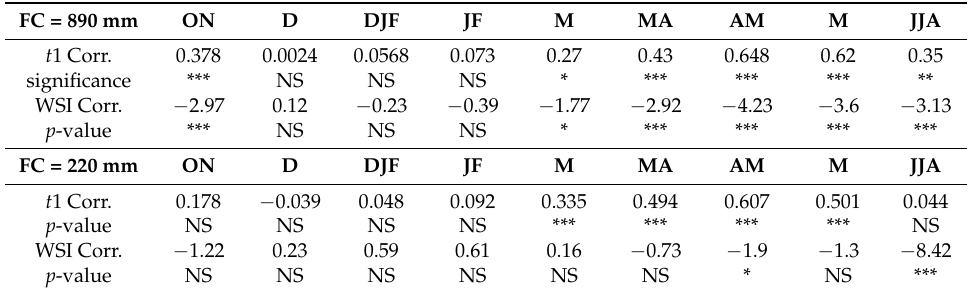
Table 4. Correlation coefficients and p -value between drought onset (t 1) and WSI (simulated from a water budget model with field capacity FC = 890 mm and FC = 220 m) with the sum of precipitations